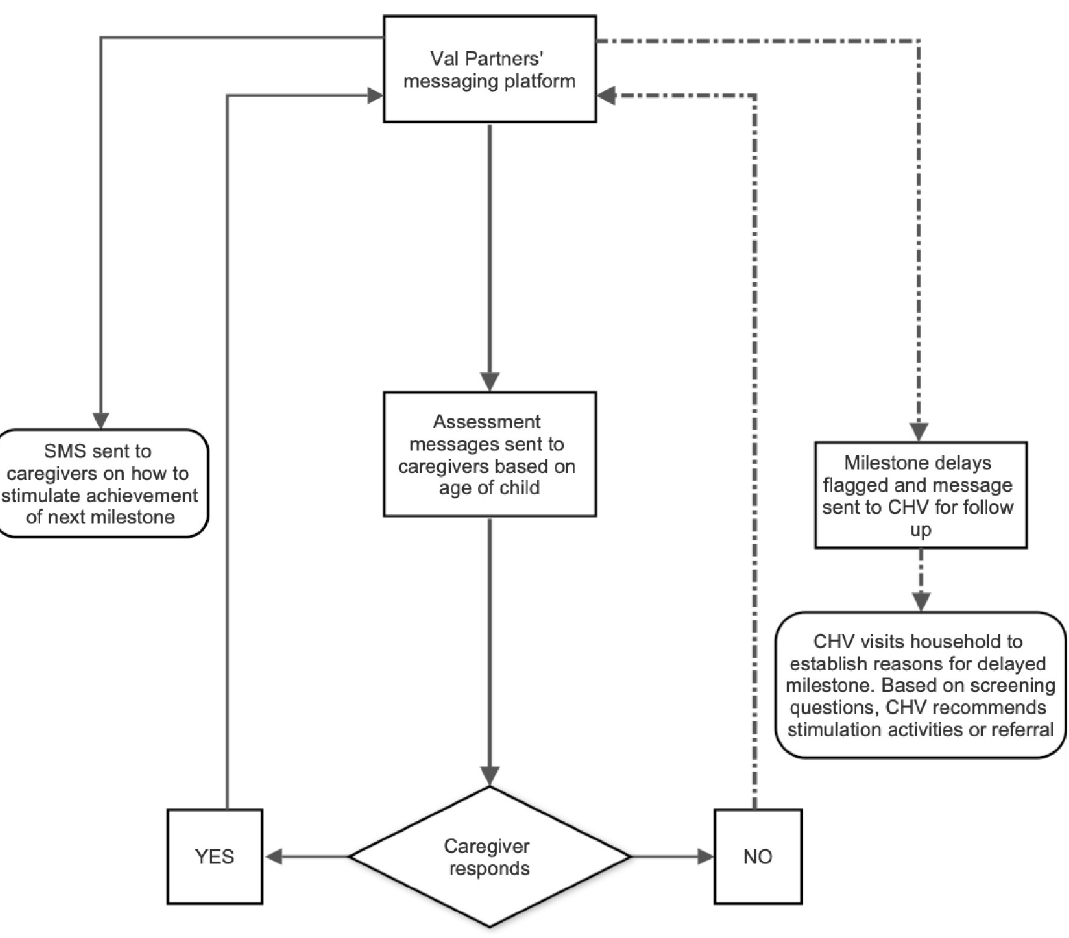
Fig 1. Flow chart showing implementation of the messaging